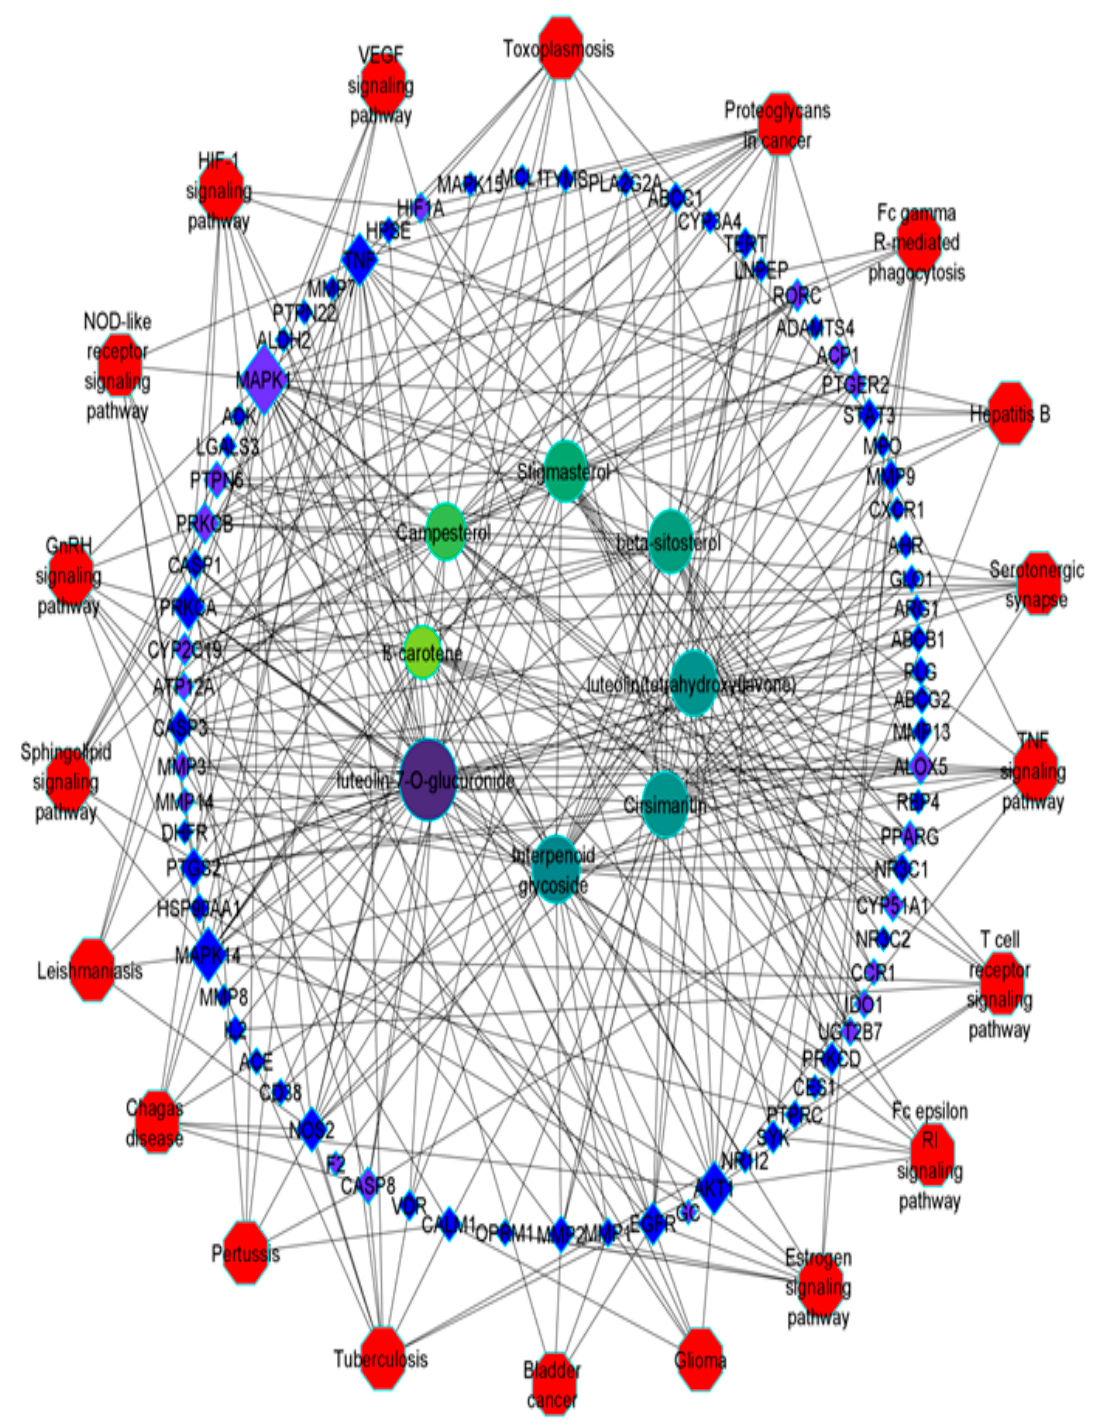
Figure 9. Target-compound-pathway network between active compounds, targets genes and enrichment pathways, node size and color show the interaction of node.